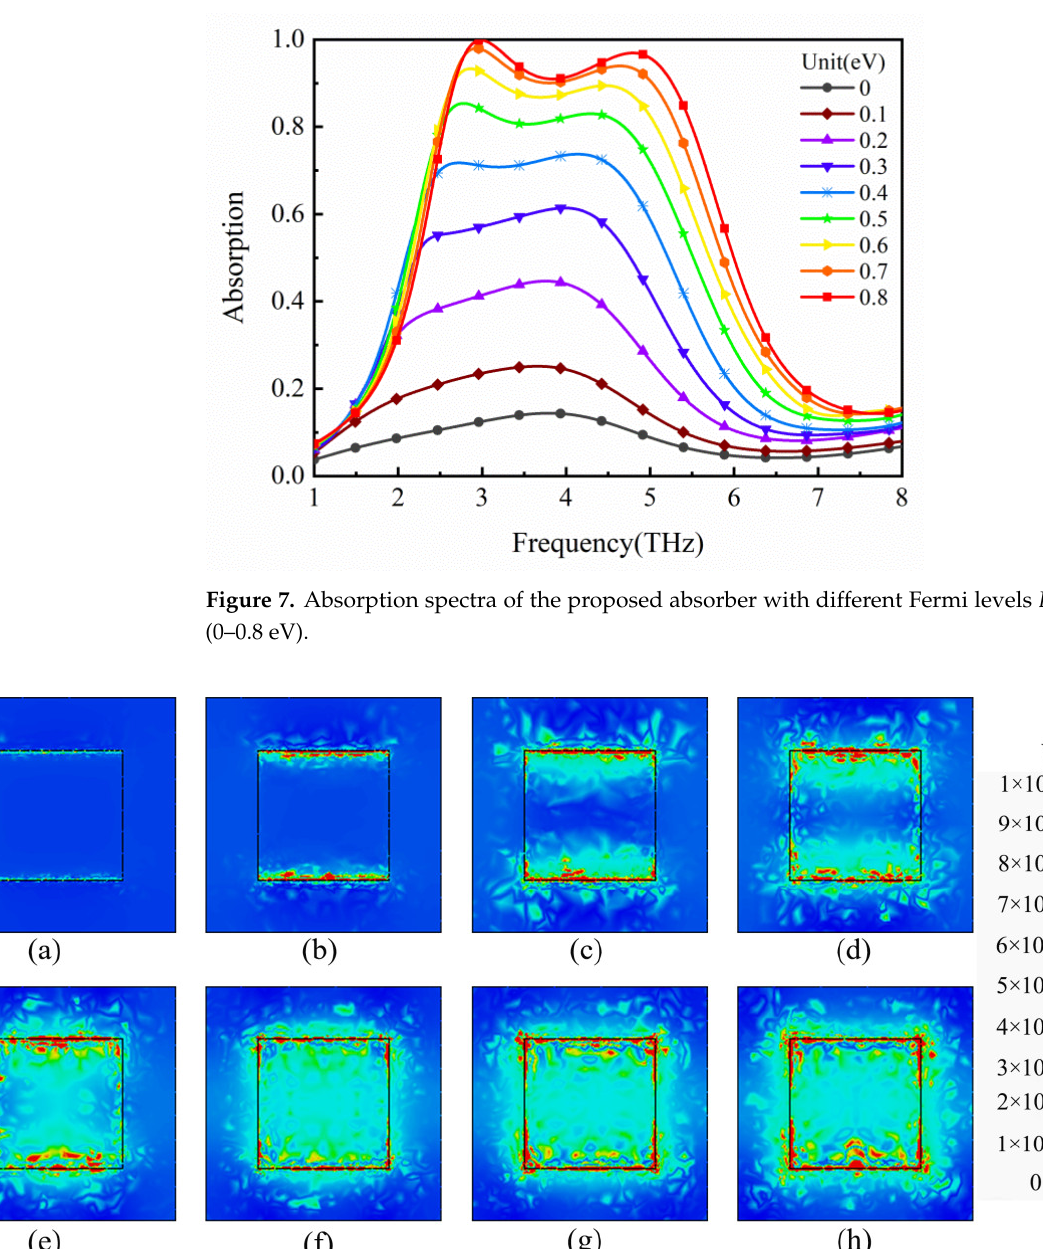
Figure 8. Electric field distributions of the graphene composite layer at the center frequency of 3.970 THz for different Fermi levels of 0–0.7 eV ( a – h ).